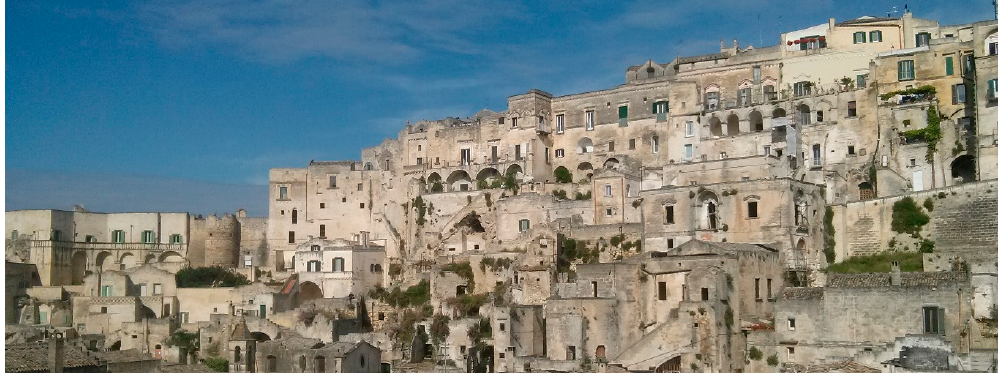
Figure 1. The Sassi site.